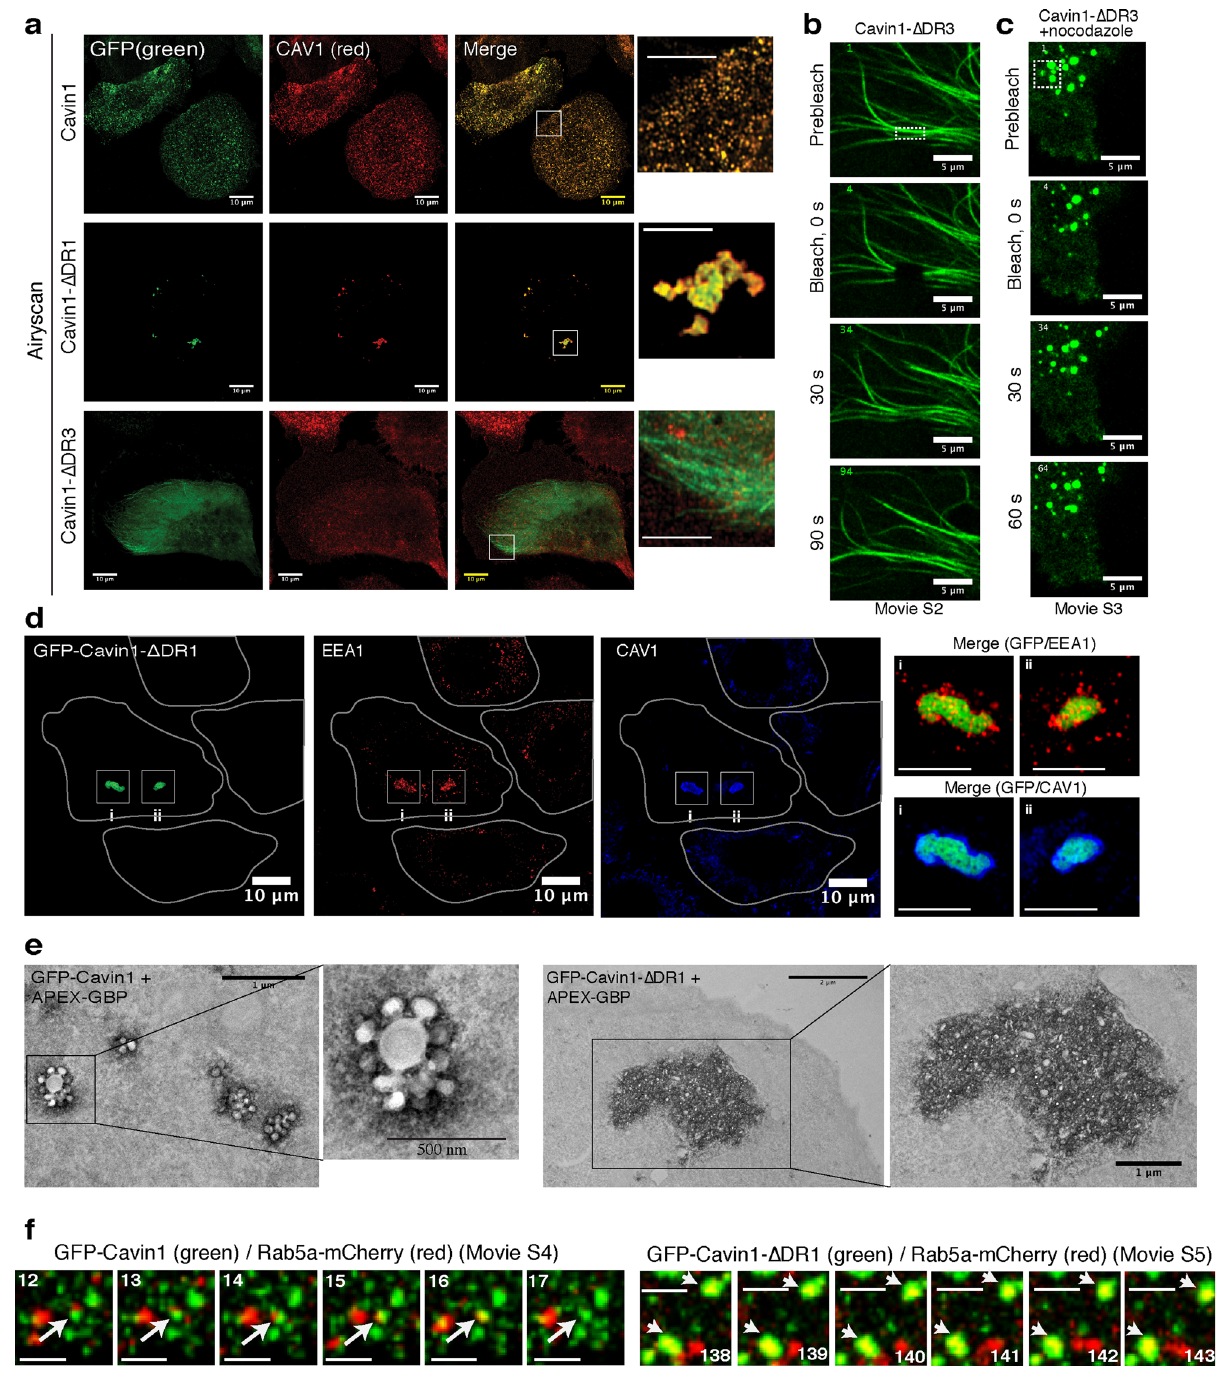
Fig. 6 The Cavin1 DR domains are essential for caveola formation with CAV1. a GFP-tagged Cavin1 and truncations (green) were expressed for 24 h in PC3 cells, fi xed and immunolabelled for Caveolin1 (CAV1) (red). Full length Cavin1 forms typical caveola puncta, colocalising with CAV1 at the cell surface. Cavin1- Δ DR1 mutant expression leads to formation of tethered intracellular CAV1-positive clusters. Cavin1- Δ DR3 shows cytoplasmic and microtubule localisation. Images were collected using a Zeiss fast Airyscan microscope. Scale bar = 10 μ m; enlarged boxes scale bar — 5 μ m. Fluorescence recovery after photobleaching (FRAP) analysis of GFP-Cavin1- Δ DR3 before ( b ) and after ( c ) nocodazole (10 µ M) addition. Scale bar — 5 μ m. d In PC3 cells GFP-tagged Cavin1- Δ DR1 truncation shows colocalization with the early endosomal marker (EEA1) (red) and CAV1 (blue). Inset shows merge images of GFP-Cavin1- Δ DR1/EEA1 and GFP-Cavin1- Δ DR1/CAV1. Scale bar = 10 μ m; enlarged boxes scale bar — 5 μ m. e GFP-tagged Cavin1 and Cavin1- Δ DR1 were visualised in PC3 cells by electron microscopy and labelling of GFP tagged proteins using APEX-GBP staining. Scale bar = 1 and 2 μ m. Enlarged boxes scale bar — 500 nm and 1 μ m. f Live imaging of PC3 cells expressing Rab5a-mCherry with either GFP-Cavin1 or GFP-Cavin1- Δ DR1. Images were acquired one frame per 4 s and frame numbers are indicated in boxes. Arrows indicate mCherry/GFP signal co-localisation or separation event. Scale bar — 2 μ m.